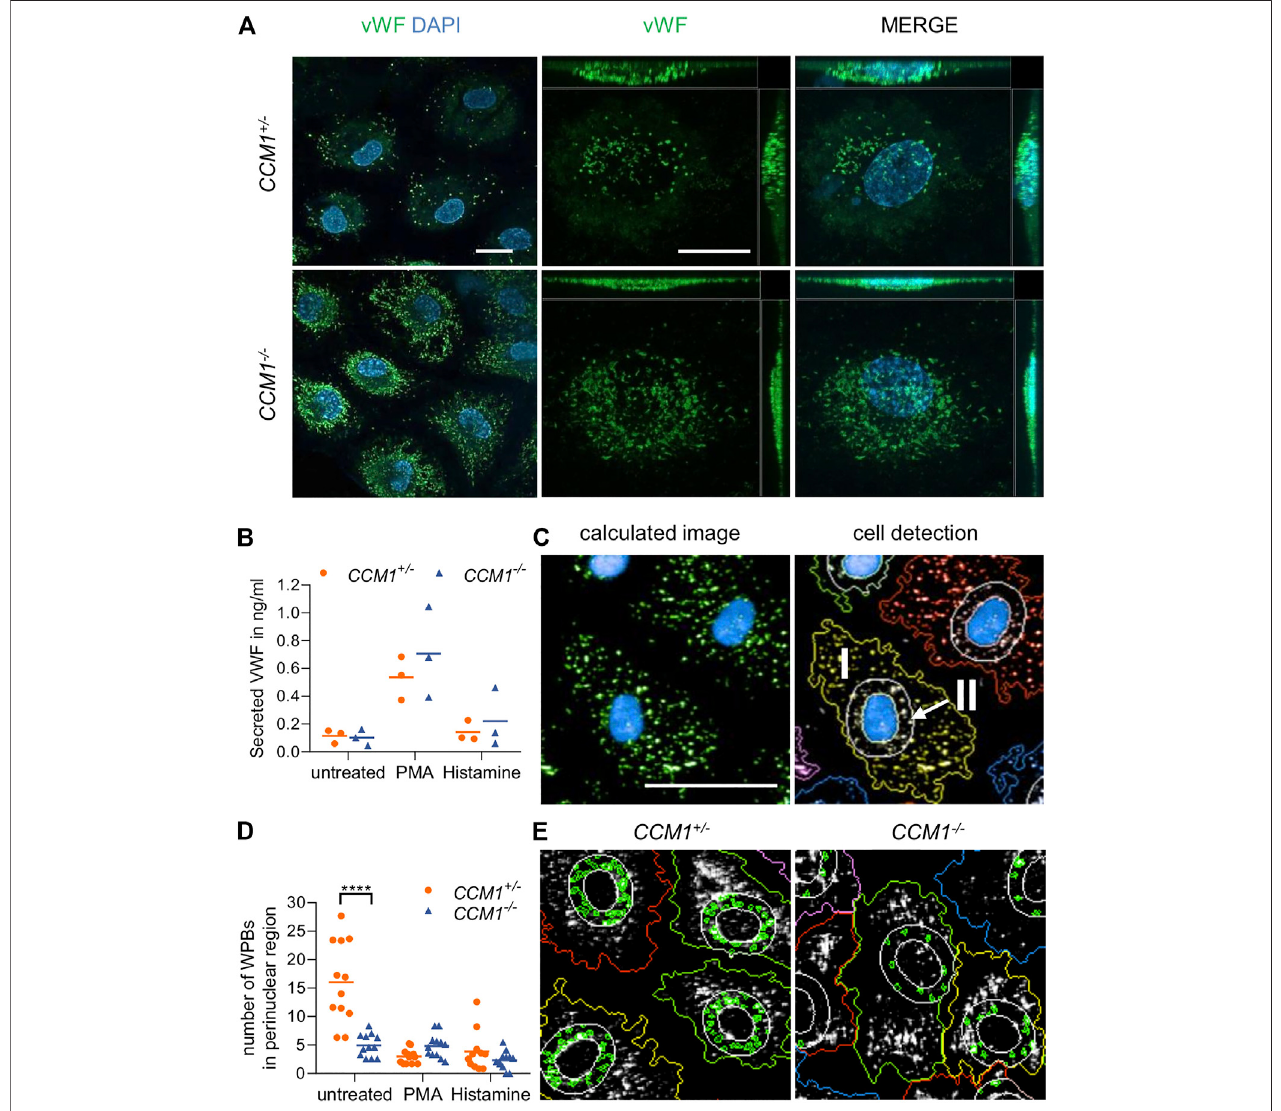
FIGURE 3 | High VWF content and aberrant WPB distribution in CCM1 − / − BOECs. (A) Immuno fl uorescent staining demonstrated high-level VWF expression (green) in clonally expanded CCM1 − / − BOECs. DAPI (blue) was used asnuclear counterstain. Confocal images were acquired using a 63x (NA 1.4) oil objective (left) and athighermagni fi cationshownasmaximumintensityprojectionofimagestacks(0.2 µmzplanes).Scalebarsindicate20 µm. (B) AbsoluteamountofsecretedVWFfrom CCM1 +/ − and CCM1 − / − BOECs as quanti fi ed by ELISA. Data are presented as single data points with the mean ( n (cid:2) 3). (C) Analysis strategy of